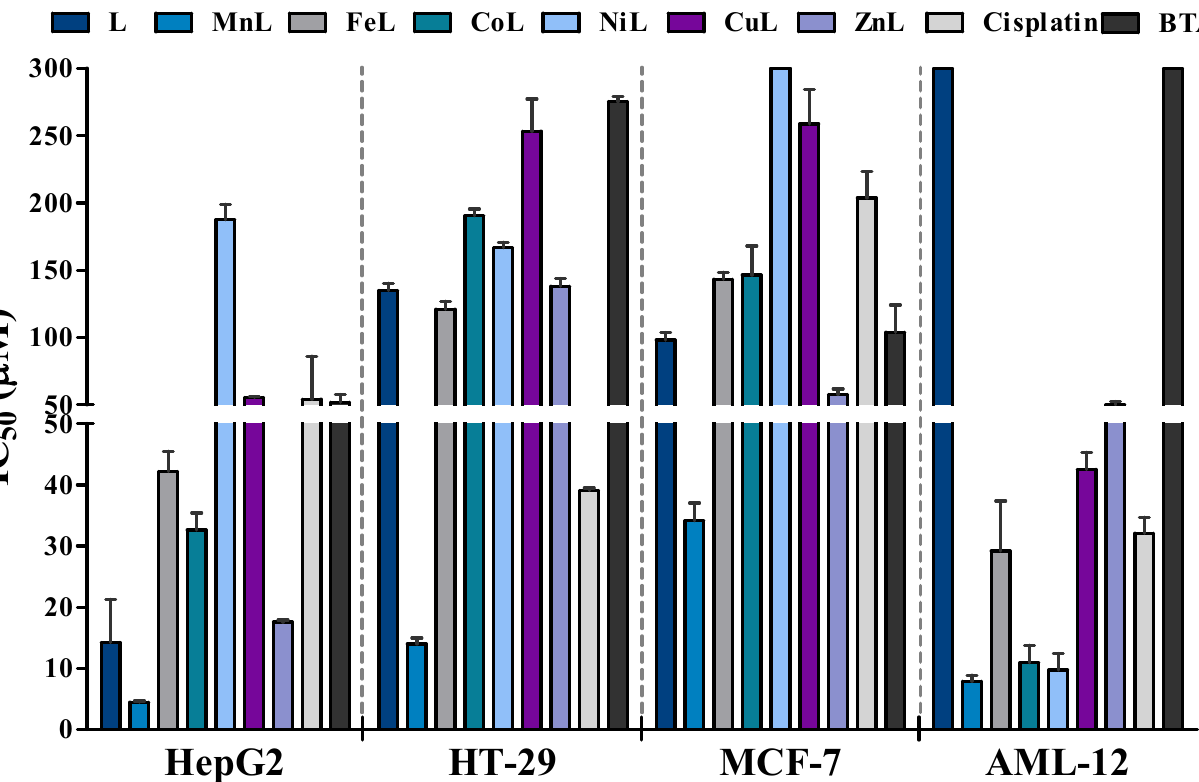
Figure 3. Graphical representation of IC 50 values for L , transition metal complexes, cisplatin, and BTA in HepG2, HT-29, MCF-7, and AML-12 cell lines. The data are representative of the mean of three independent experiments ( n = 3, mean ± SEM).